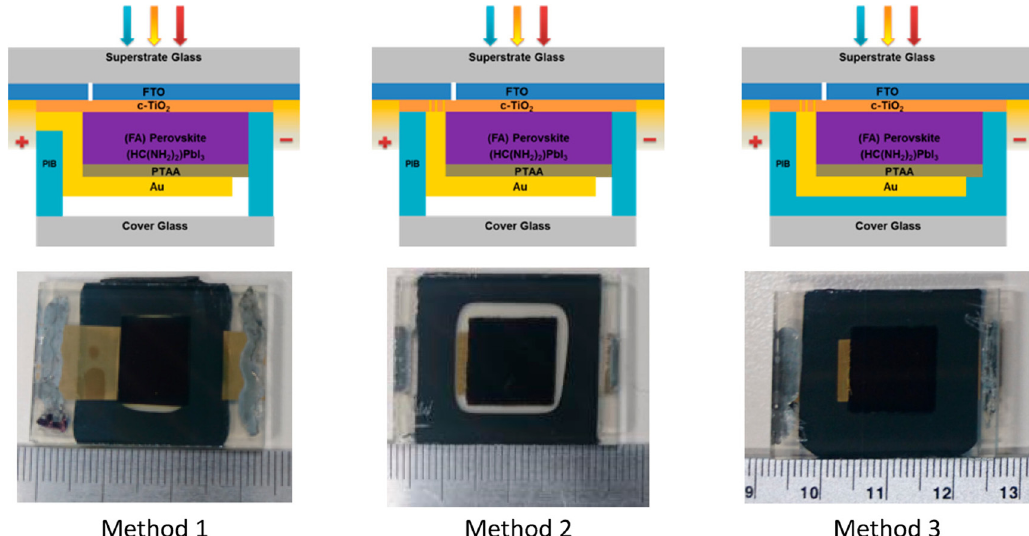
Figure 9. Cross-sectional schematics with the photographs of perovskite solar cells encapsulated by three different methods [188]. From Ref. [188]. Copyright 2017 ACS Applied Materials and Interfaces.